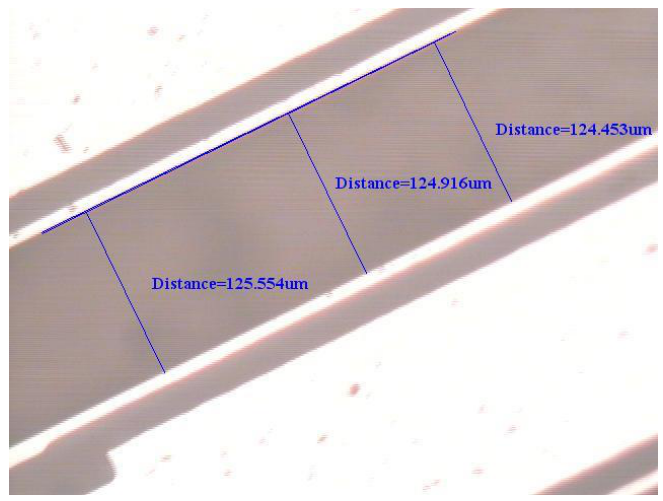
Figure 14. Determination of the gap between the two prongs from a microscope image.